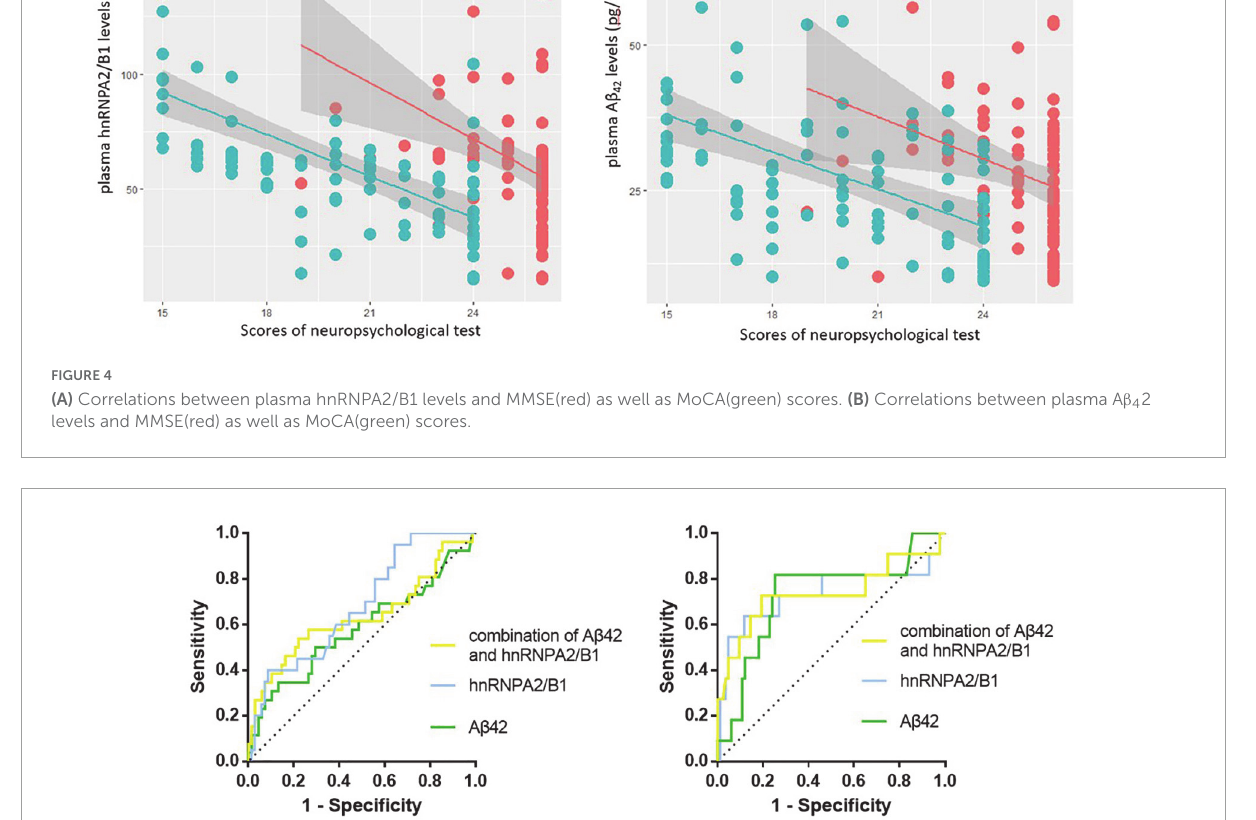
of hnRNPA2/B1 are the critical components that drive liquid–liquid phase separation (LLPS) and subsequently contribute stress granule (SG) to the hydrogel phase transition (Lee et al., 2016), while the latter is the key mechanism